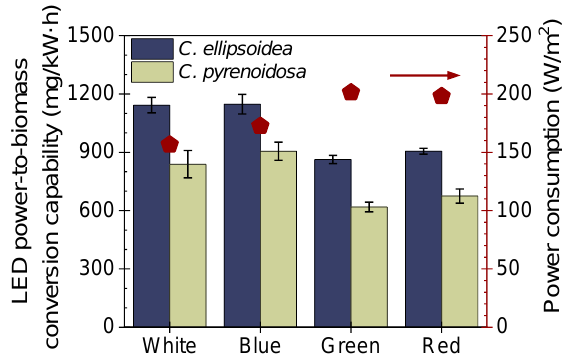
Figure 4. The LED power-to-biomass conversion capability of microalgae cultured under different LEDs (blue and drab column), and power consumption of different LEDs (red pentagon ).